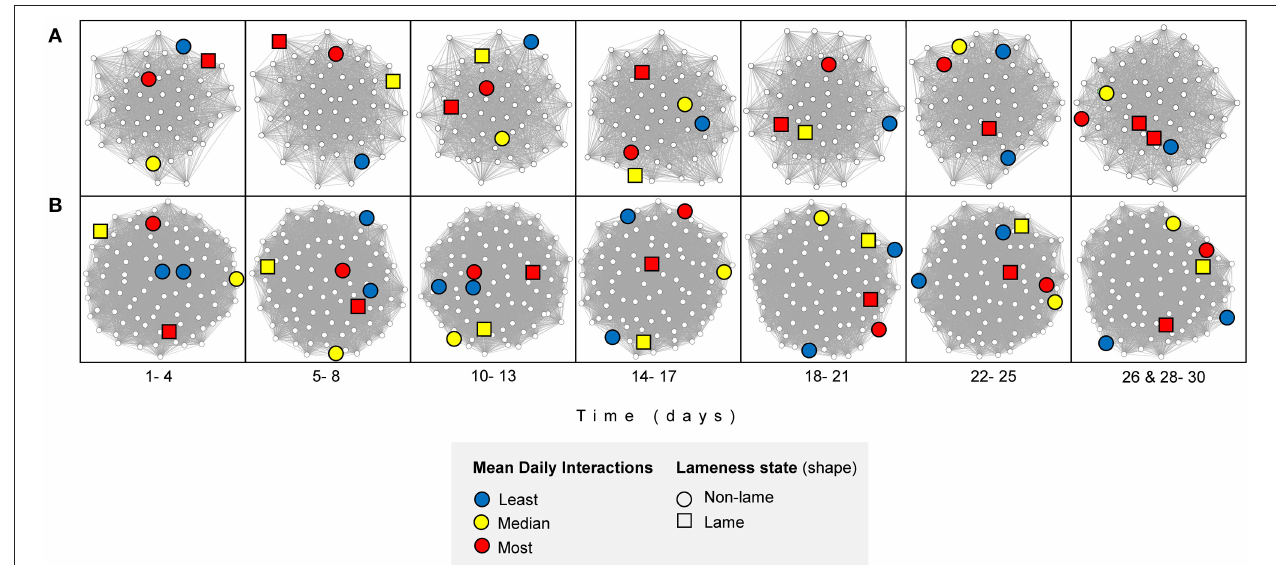
FIGURE 5 | Interaction networks, filtered by mean node degree, over time for (A) feeding zone, and (B) non-feeding zone. An illustrative subset of individuals are highlighted: two individuals with the least mean daily interactions (blue, cow ID = 3124 and 3317), two with mean daily interactions closest to the median value (yellow, cow ID = 2602 and 3132) and two with the highest mean daily interactions (red, cow ID = 635 and 3361). The Fruchterman-Reingold layout algorithm determined the node positions; unconnected vertices are repelled. Created in RStudio using the “vegan” package (68, 69,